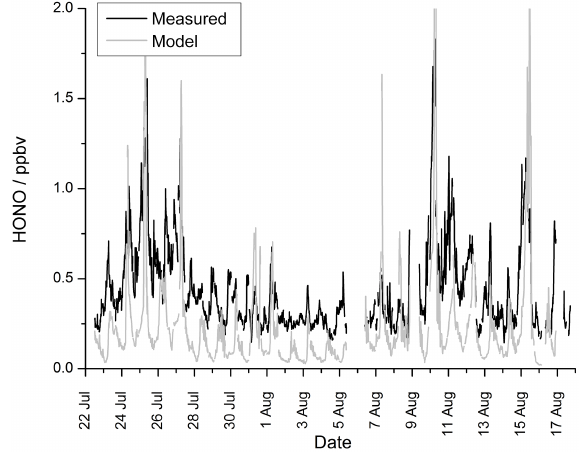
Figure 5. Average daytime diurnal profile of the modelled HONO from different sources shown as a compound area plot, as described in Sect. 3.3 of the text. Also plotted (black trace) is the measured HONO.